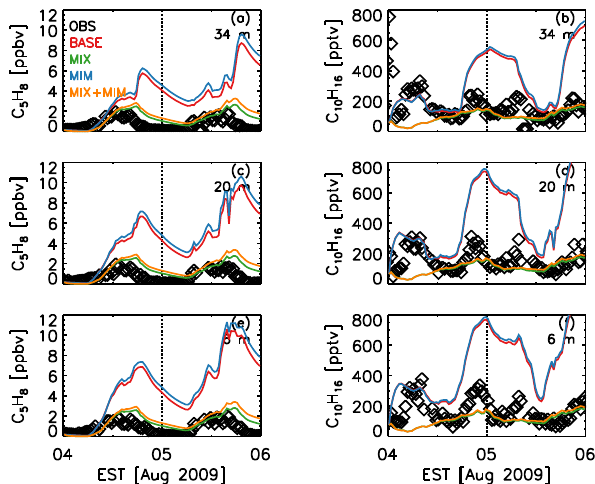
Fig. 6. Same as Fig. 5, but for (a, c, e) isoprene and (b, d, f) monoter-